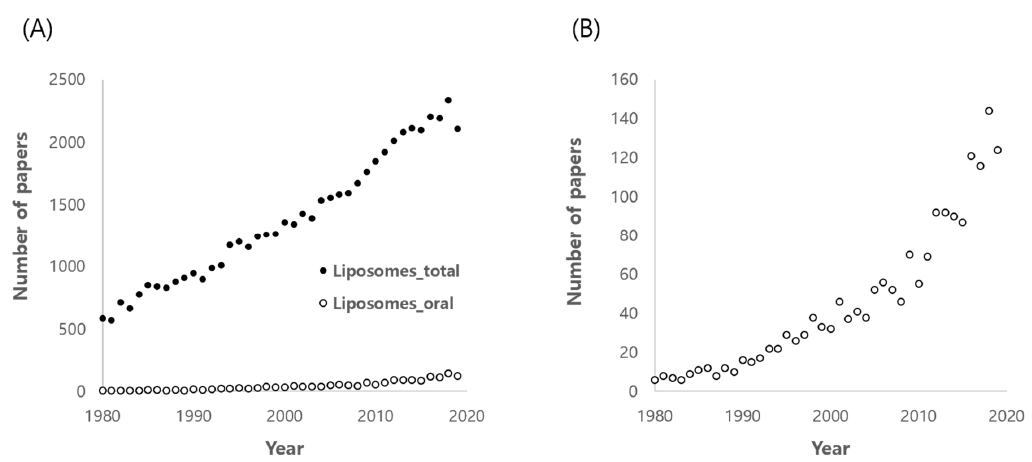
Figure 1. Number of papers published from the years 1980 to 2000. The numbers were obtained from a Pubmed search using keywords of liposomes (Liposomes_total) or liposomes and oral (Liposomes_oral). ( A ) represents both results, ‘Liposome_total’ and ‘Liposomes_oral’, for comparison. ( B ) represents ‘Liposomes_oral’ only to show the increasing trend.